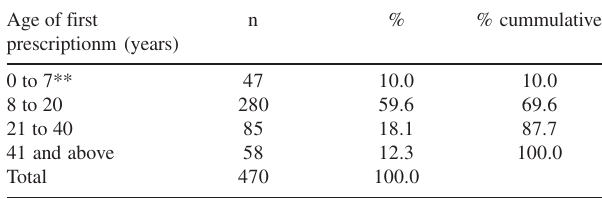
Table 5 - Age of first optical prescription (eyeglasses) Age of first n % % cummulative prescriptionm